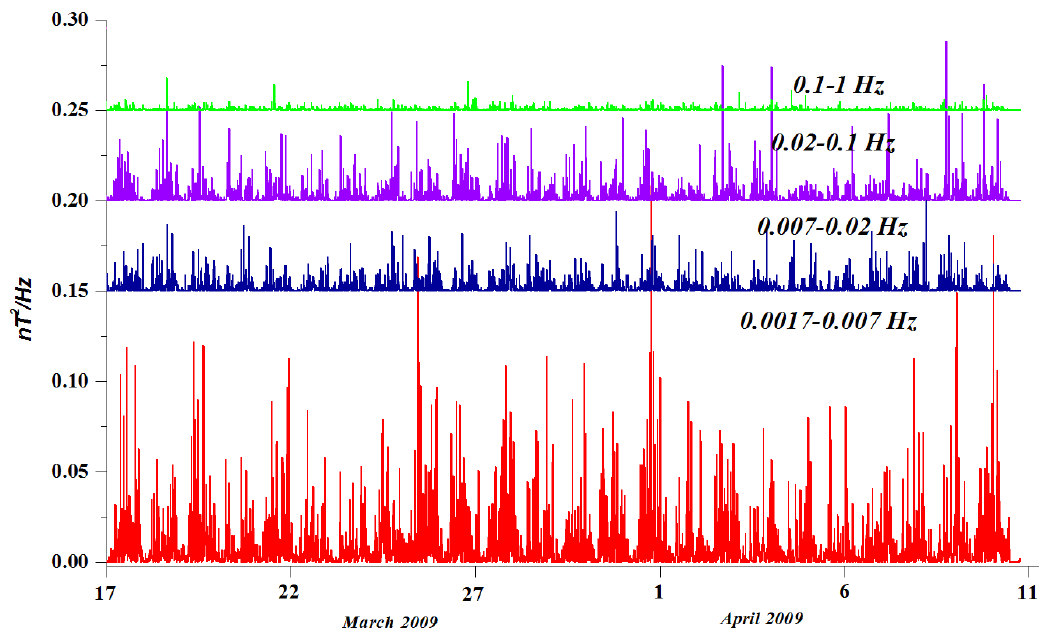
Figure 17. Diurnal variation of magnetic intensity field (component Z) observed at L’Aquila in the frequency band from 0.0017 Hz to 1 Hz, not scaled adopted from Di Lorenzo et al.